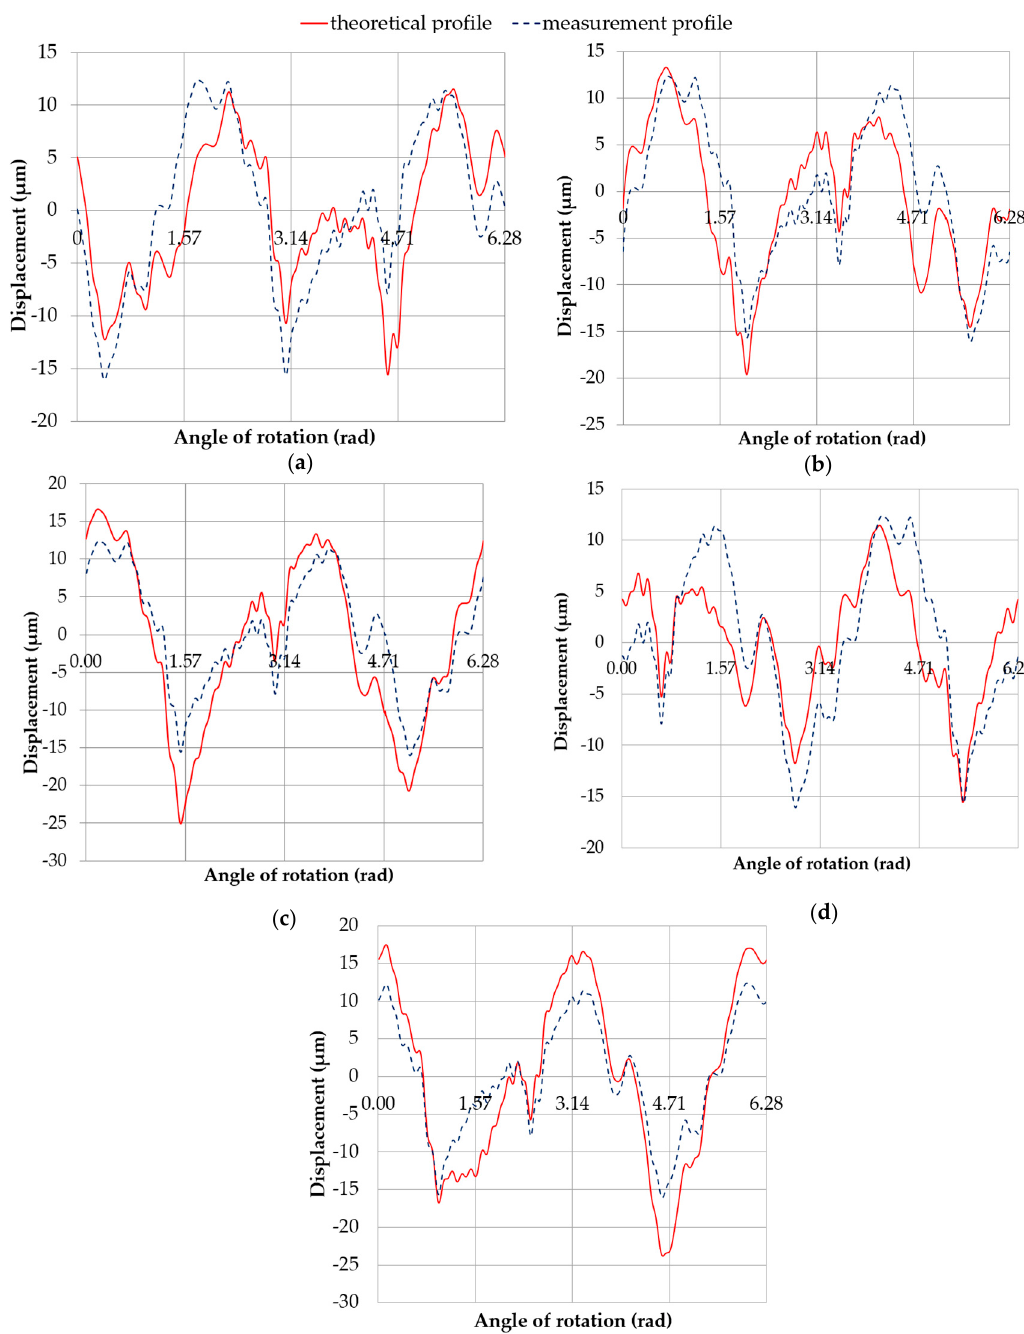
Figure 25. Measured and theoretical profiles (excluding harmonic component no. 1) obtained by superimposing the measured roundness profile of journal no. 5 onto the eccentric movement profile of the center of the measured roundness profile with the supports set at the same height ( x = 0 mm), with an eccentricity of the main journal e = 0.03 mm, ( a ) at a starting position; ( b ) rotated 60°; ( c ) rotated by 90°; ( d ) rotated by 225°; ( e ) rotated by 300°.